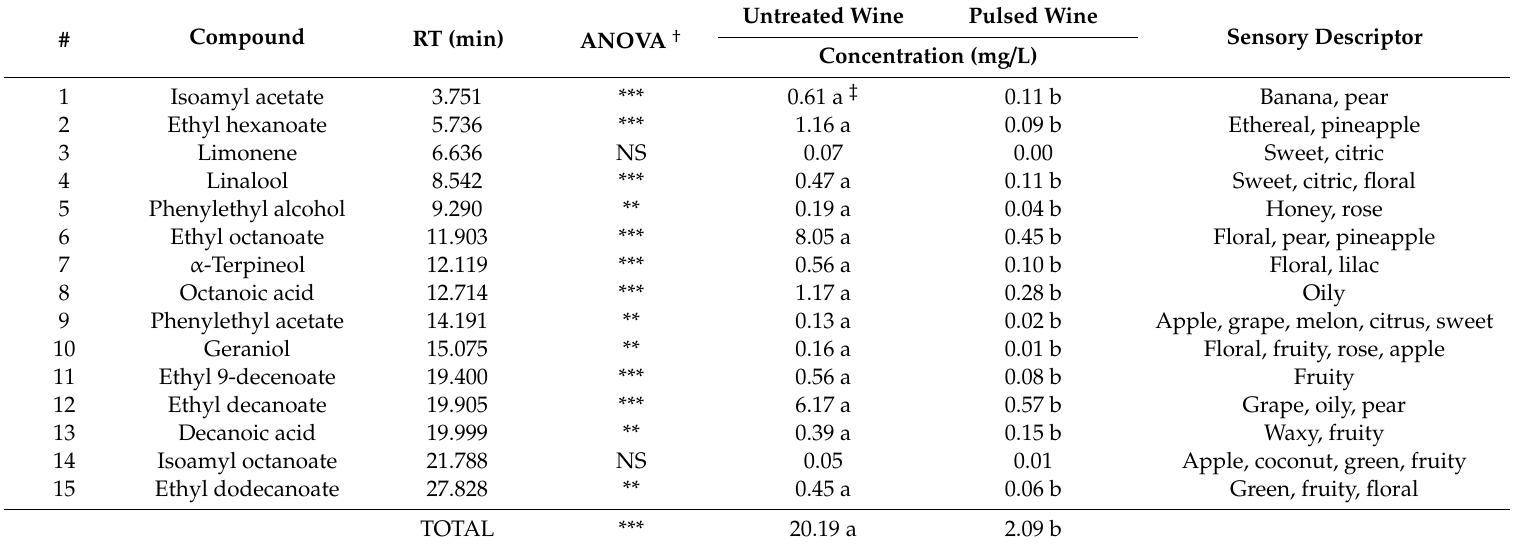
Table 2. Volatile compounds of wines subjected to pulsed light (10.7 J / cm 2